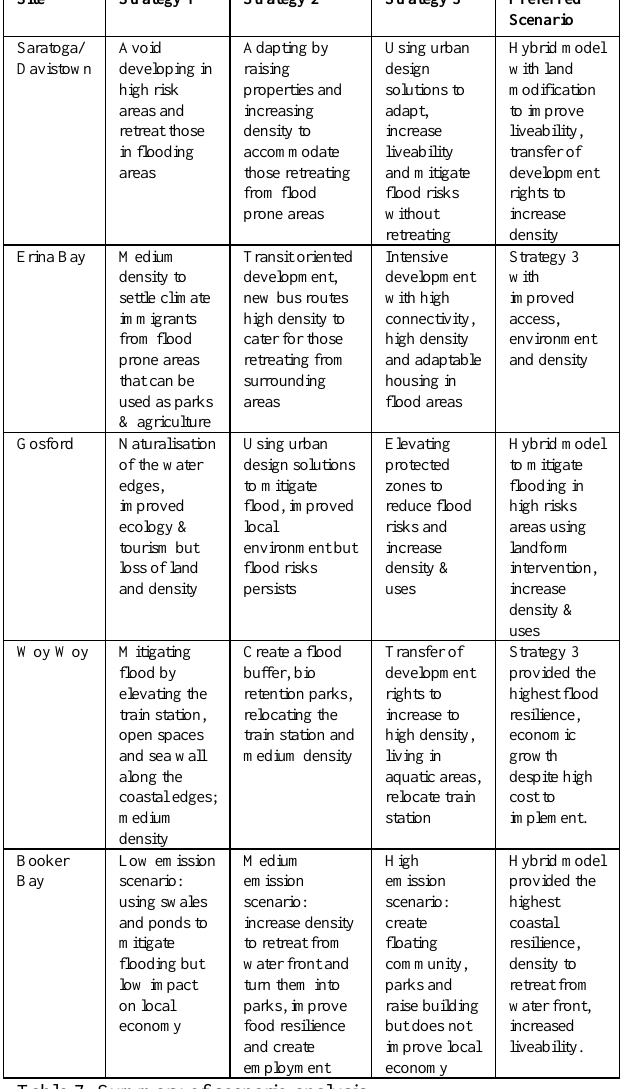
Table 7: Summary of scenario